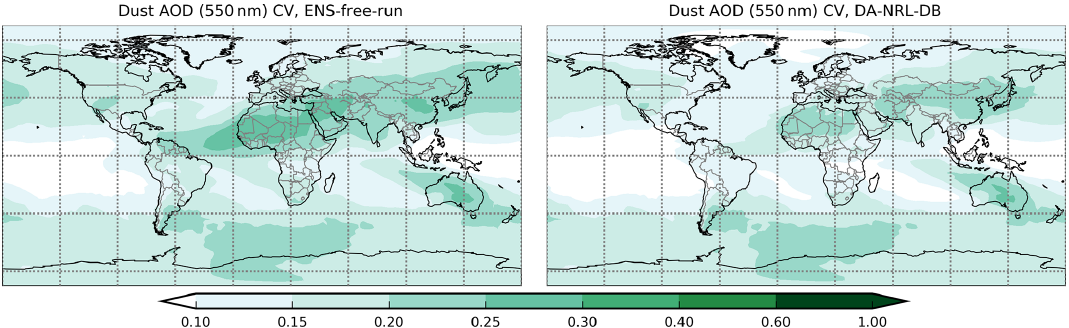
Figure 8. Coefficient of variation for the month of May 2007 for the ENS-free-run (left) and DA-NRL-DB (right) experiments, when the ensemble is created perturbing the emitted mass vertical flux for each dust bin. Table 3. Statistics of departures of first guess and analysis from assimilated observations, calculated for May to August 2007. Experiment